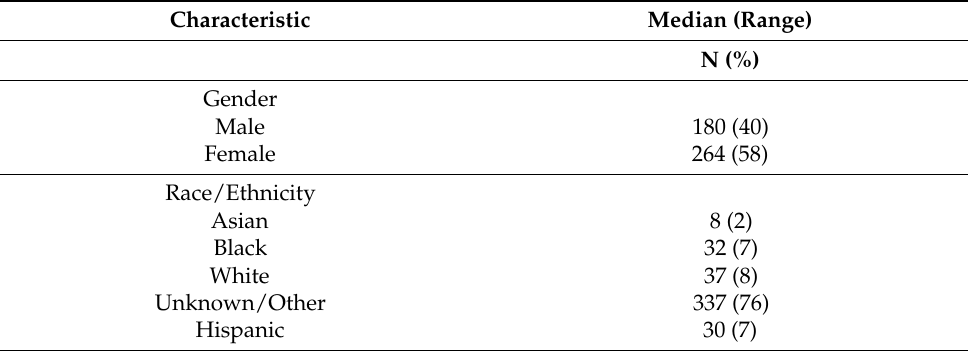
Table 1. Baseline characteristics for participants ( n = 444). Characteristic